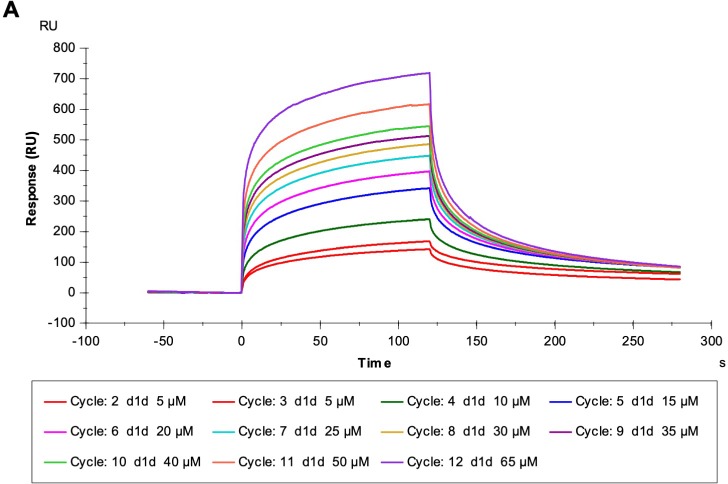
Representative Sensorgram obtained when D1d solutions at the indicated concentrations were flowed across the Aβ1–42 sensor chip.The data of flow cell 1 (blank control) was subtracted from the data of flow cell 2.